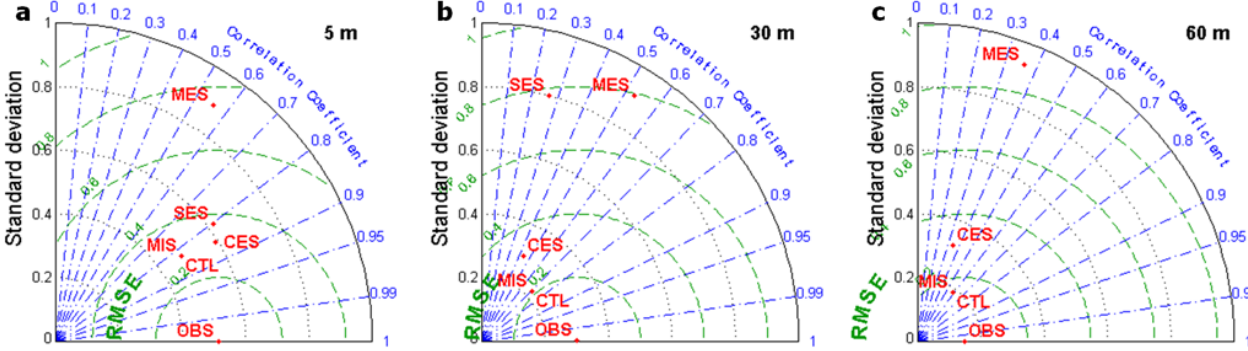
Fig. 13. Taylor diagram indicating model performance for water temperature at (a) 5m, (b) 30m and (c) 60m depths for different initial conditions at Ishungu (January 2003–December 2011). OBS: observations, CTL: control, CES: control excluding spin-up, SES: stratified excluding spin-up, MIS (MES): mixed warm initialisation including (excluding) spin-up. Note that SES is omitted at 60m given its strong deviation from observations there.